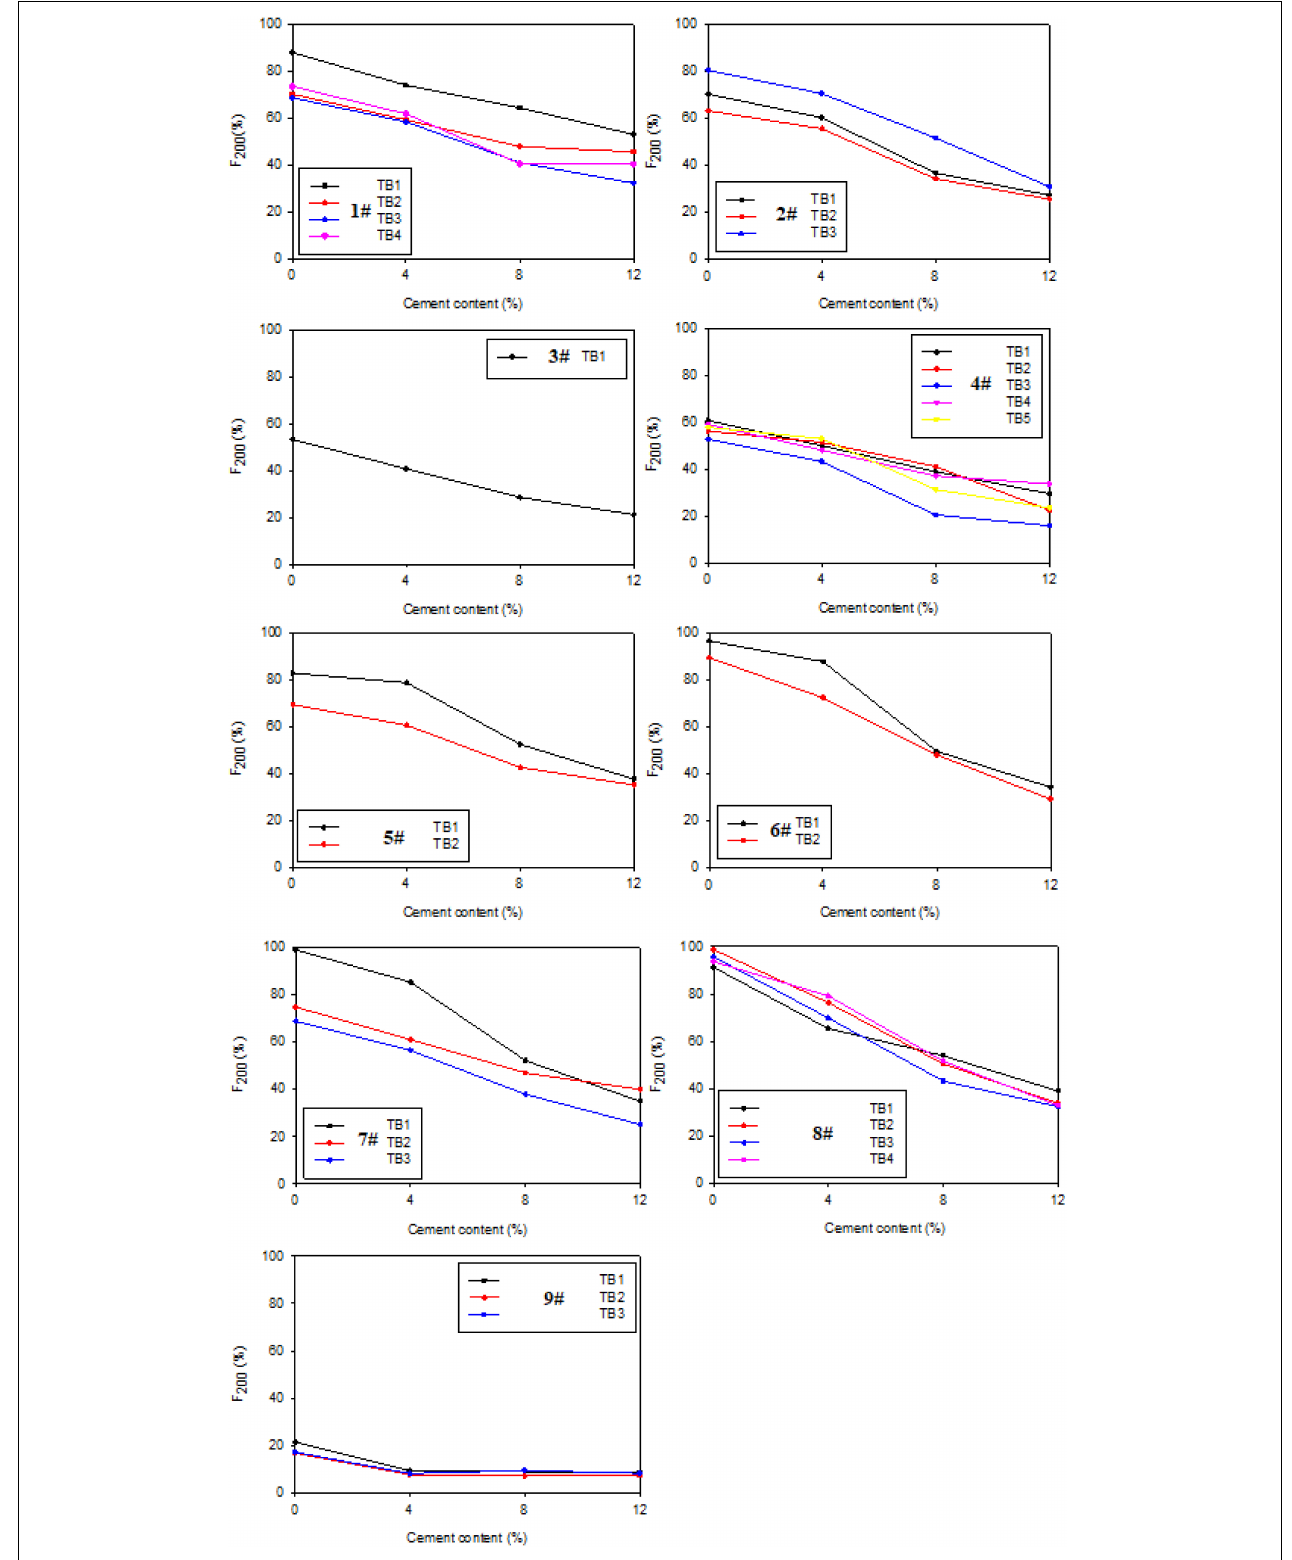
FIGURE 2 | F 200 versus cement